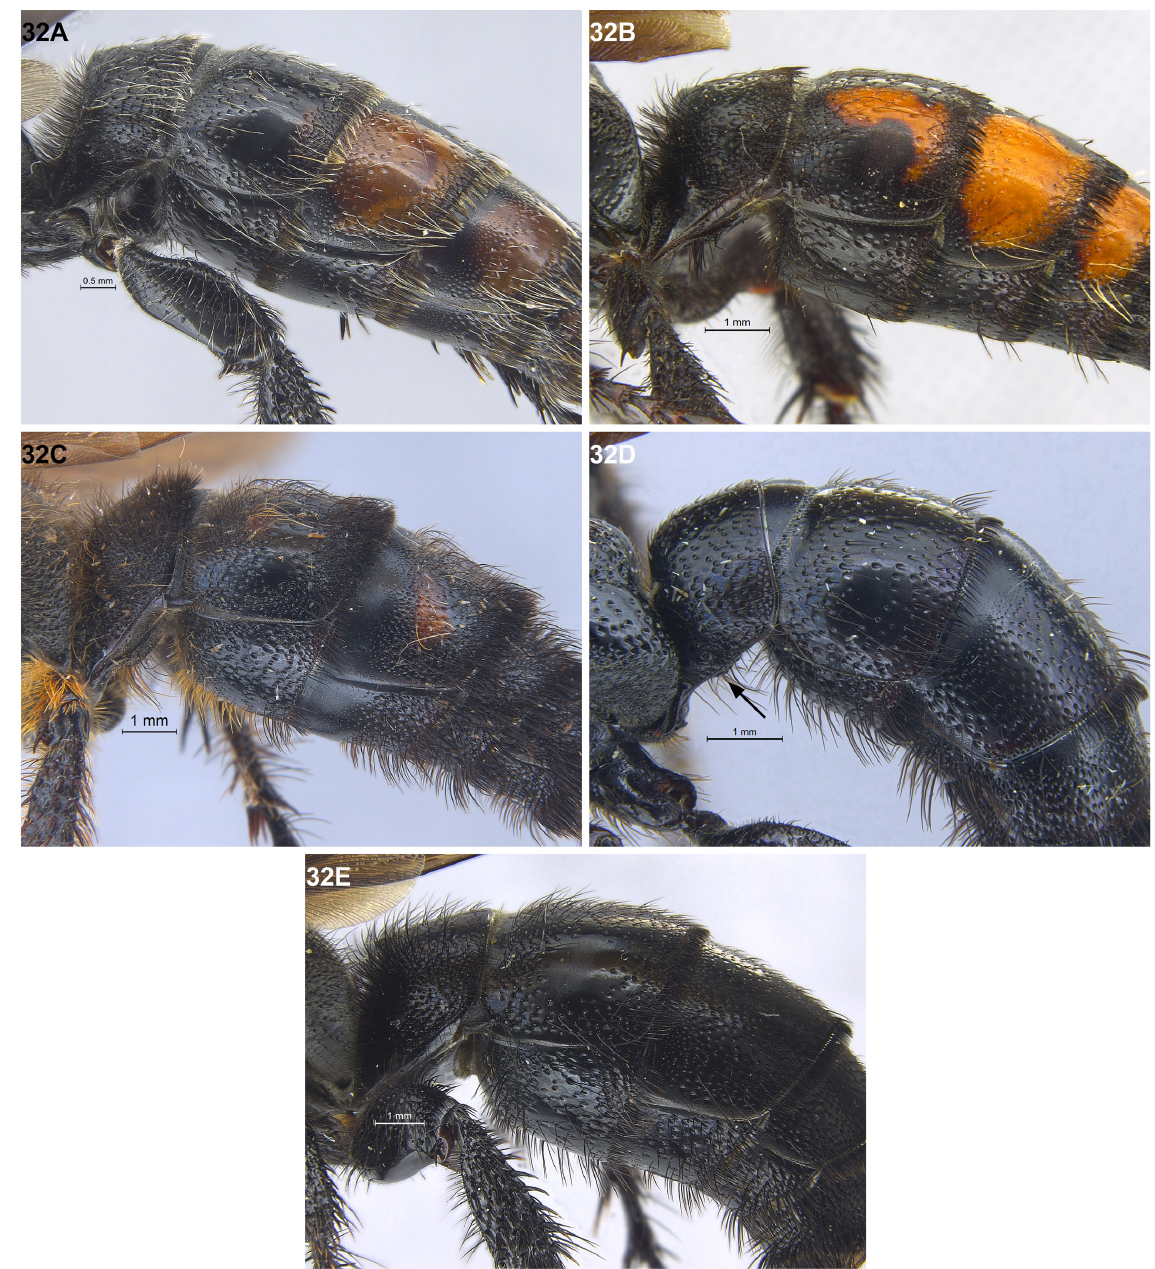
Fig. 32. Females, T1–T3, lateral view. A . Scolia binotata Fabricius, 1804 . B . Sc. binotata orange